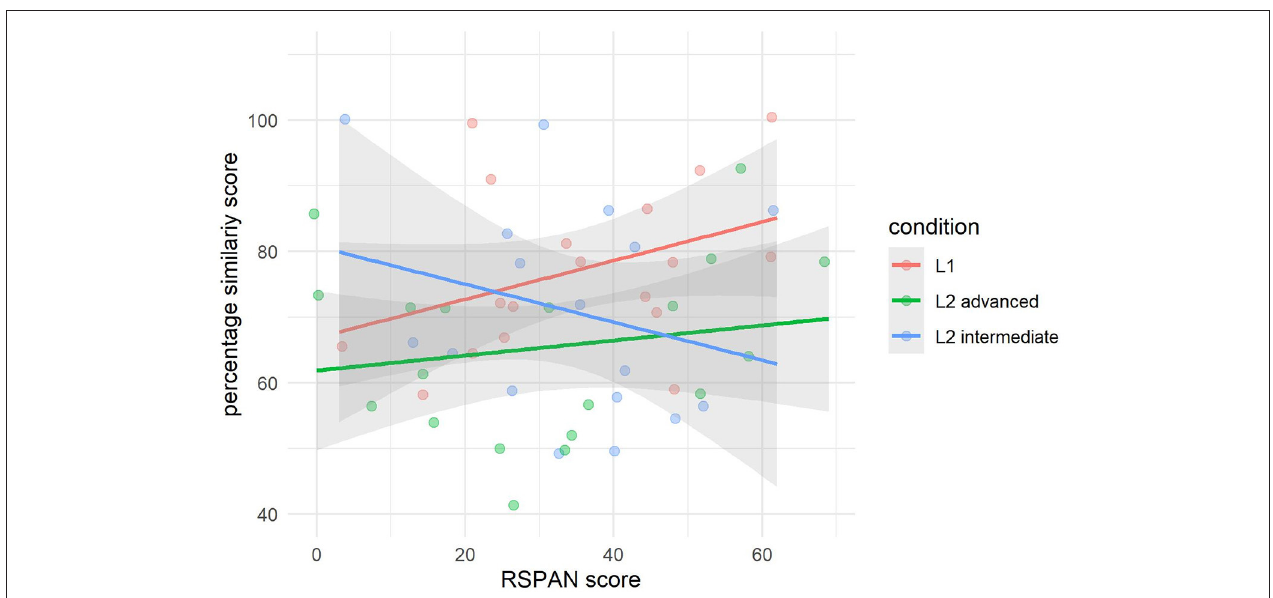
FIGURE 2 | Recall as mediated by condition and